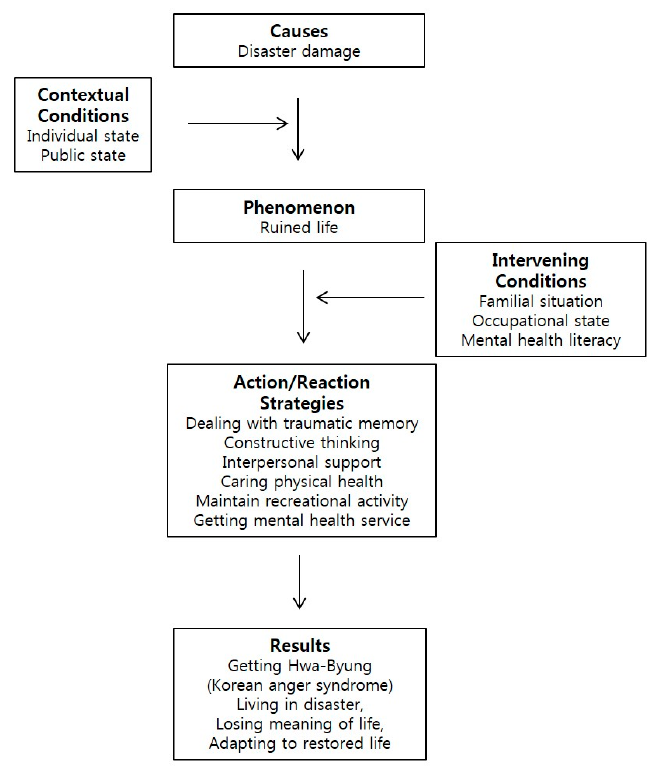
Figure 2. Korean’s coping process for mental health recovery from disaster .